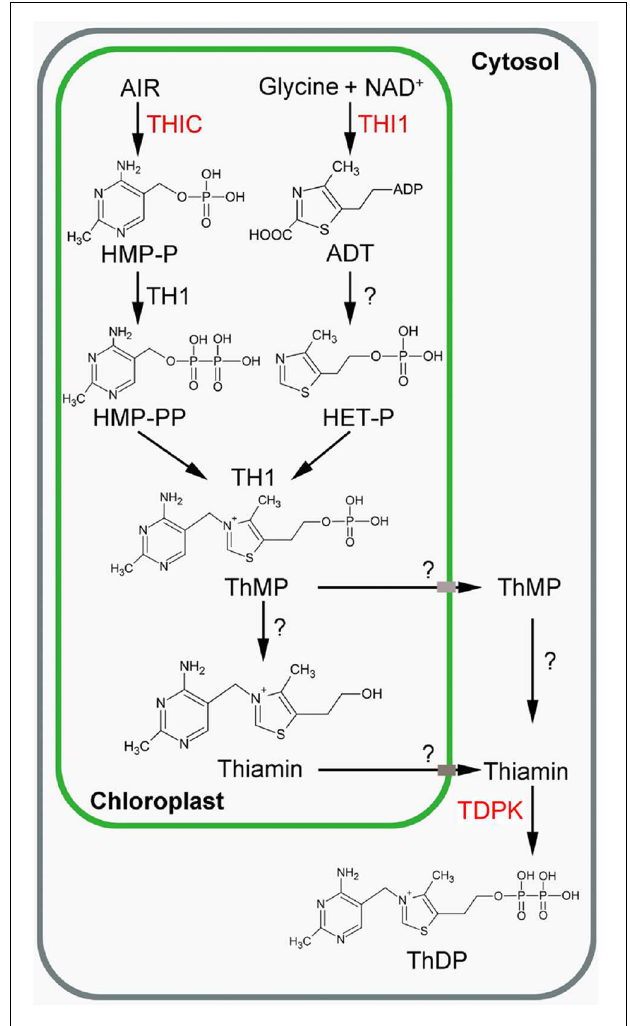
FIGURE 1 | Thiamin biosynthesis in plants (Source: Dong et al., 2015). Engineered enzymes are in red. ADT, adenosine diphospho-5-( β -ethyl)-4-methylthiazole-2-carboxylic acid; AIR, 5-aminoimidazole ribonucleotide; HET-P, 4-methyl-5- β -hydroxyethylthiazole phosphate; HMP-P, 4-amino-2-methyl-5-hydroxymethylpyrimidine monophosphate; HMP-PP, 4-amino-2-methyl-5-hydroxymethylpyrimidine diphosphate; NAD, nicotinamide adenine dinucleotide; ThMP, thiamin monophosphate; ThDP, thiamin diphosphate; THI1, HET-P synthase, THIC; HMP-P synthase; TDPK, Thiamin diphosphokinase; TH1, HMP-P kinase/ThMP pyrophosphorylase. The question mark indicates that the gene/enzyme has not been characterized